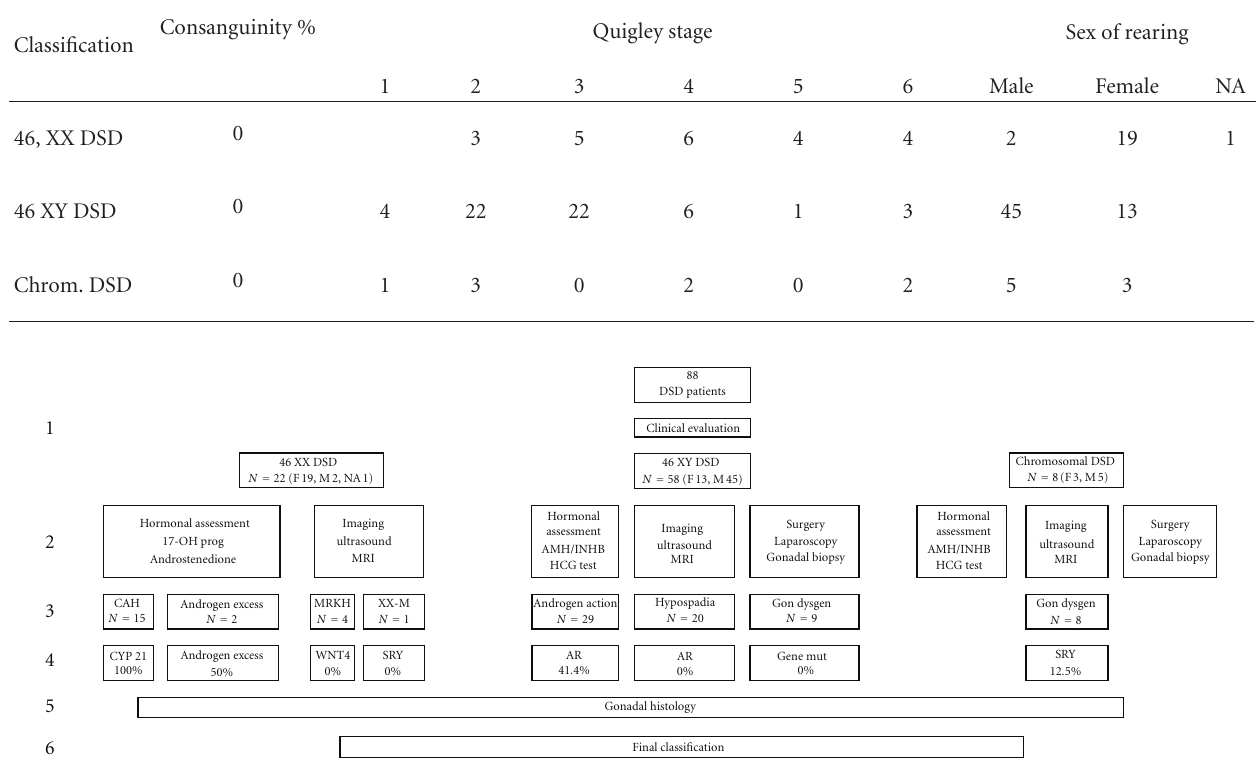
Table 1: Phenotype (Quigley stage) in correlation with the DSD classification and sex of rearing. NA: not assigned, patient died after inclusion but before gender assignment.